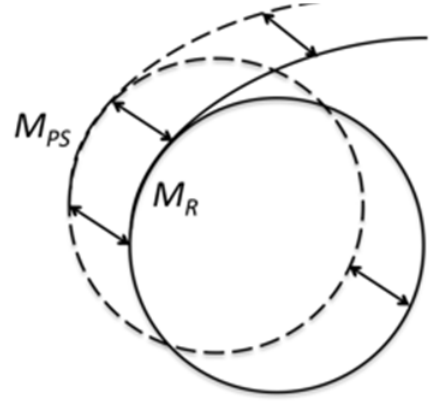
Figure 1. The tandem